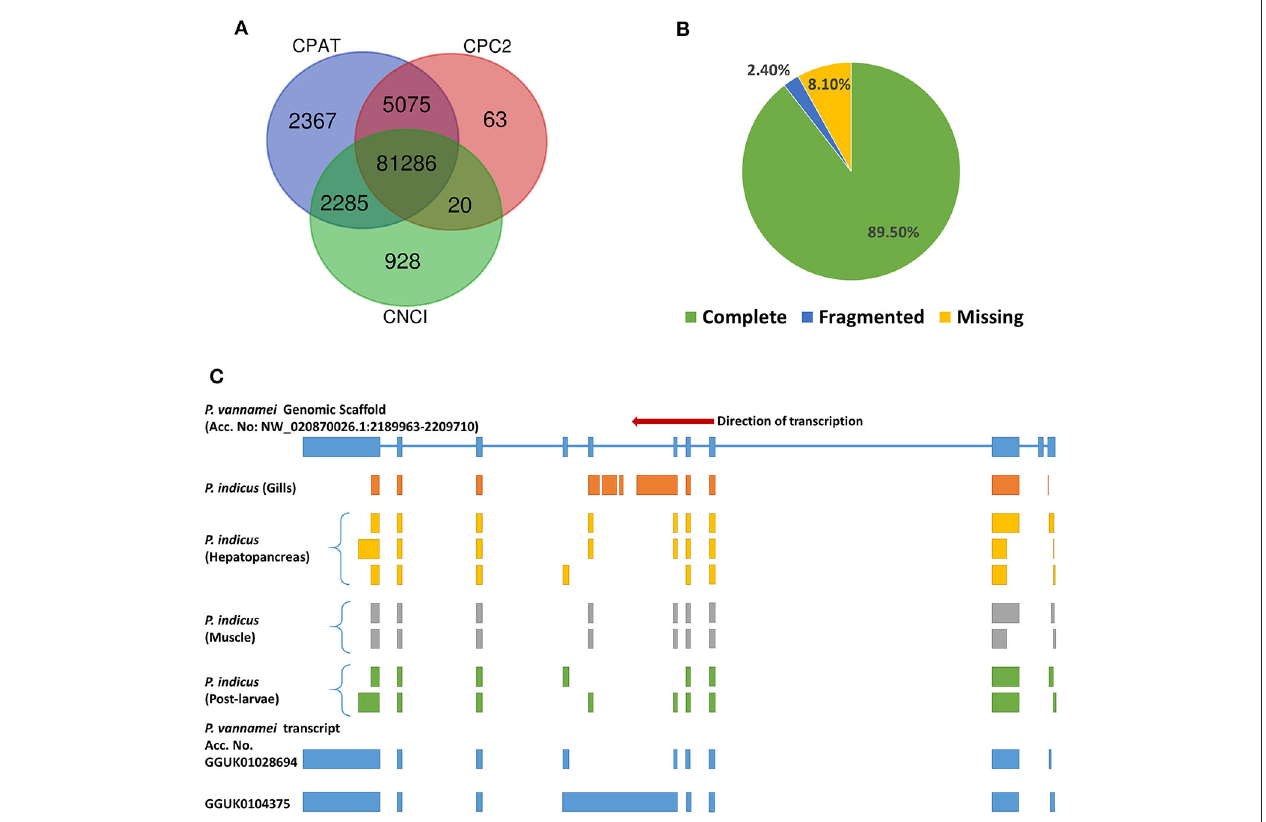
FIGURE 1 | Transcriptome assembly of P. indicus . (A) The number of coding transcripts identified through analysis of high-quality transcripts ( n = 99,458) in CPAT, CNCI and CPC2 tools. A high-quality transcript identified as ‘coding’ by atleast one of these 3 tools, is finally classified as “coding.” (B) Benchmarking the assembled transcripts against BUSCO orthologs for completeness. (C) Tissue-specific isoforms of choline phosphotransferase (CP) gene in P. indicus displaying isoform diversity. The transcripts of CP gene from each sample of P. indicus were aligned against the P. vannamei genomic scaffolds (ASM378908v1). The scaffold with positive hit (NW_020870026.1) has CP gene between bases 2189963 and 2209710. Each of the P. indicus CP transcripts was mapped to the NW_020870026.1 to identify the splice pattern. Similarly, the iso-seq transcripts of P. vannamei (Accession No. GGUK00000000) were also screened for CP gene to validate the exon junctions against the P. vannamei genomic scaffold. Each block in the figure represents an